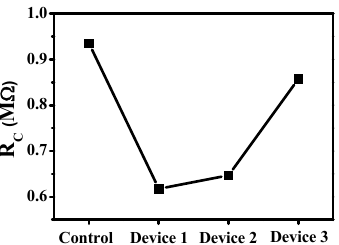
Figure 3. The R C value as a function of F 4 TCNQ:pentacene ratio of TC pentacene ‐ based OTFTs for V DS and V GS values of − 2 and − 20 V, respectively.